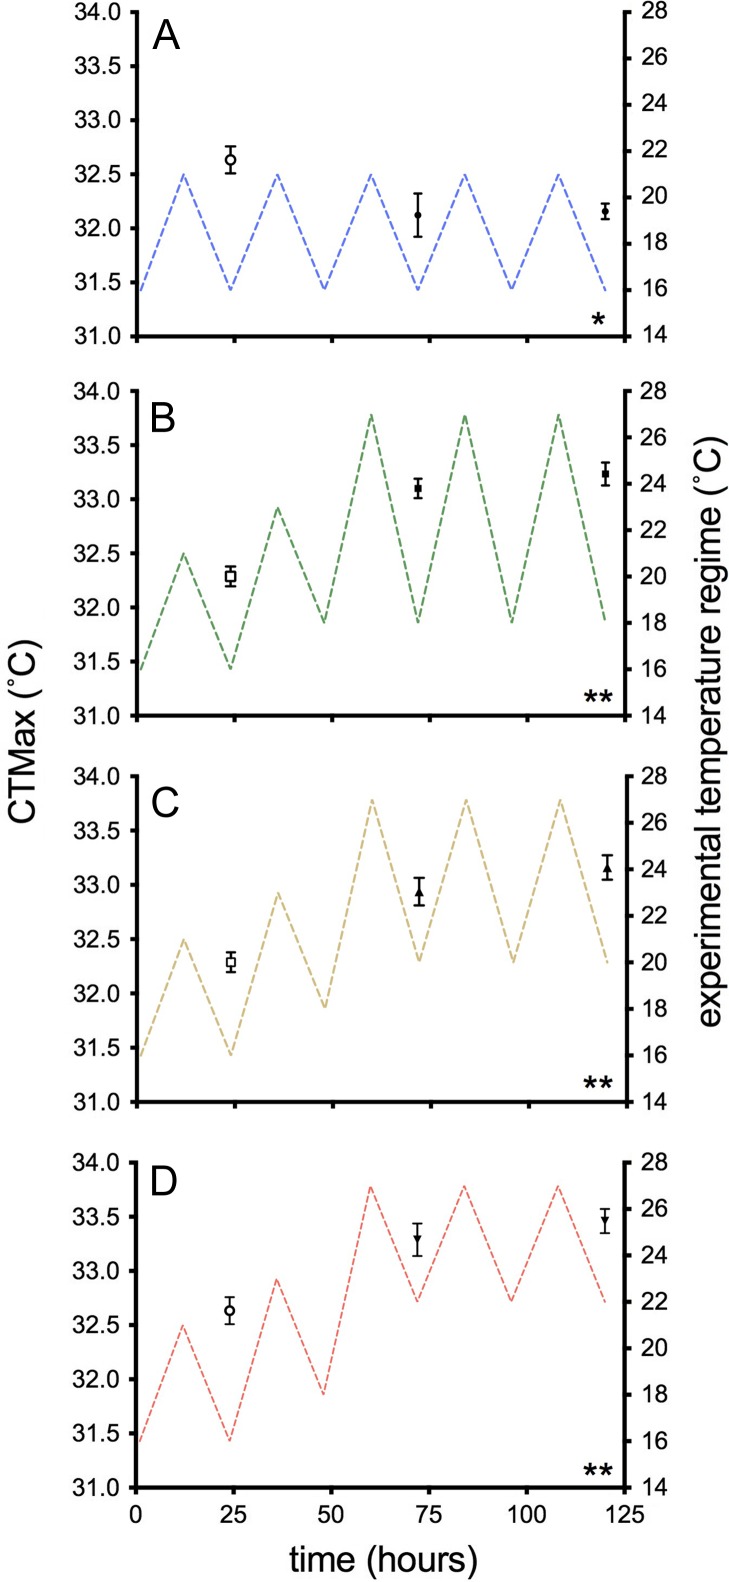
CTMax of wild juvenile salmon exposed to diel cycles: (A) 16–21°C (control group); or multi-day thermal stress (closed symbols; 60–120 h) of (B) 18–27°C; (C) 20–27°C; (D) 22–27°C. Data are presented as mean ± SEM (n = 5–10). Open symbols (t = 24 h) represent pre-thermal stress sampling time points and were secondarily used to assess the effect of ‘trial’. Asterisks indicate significant differences among treatments (P < 0.05).